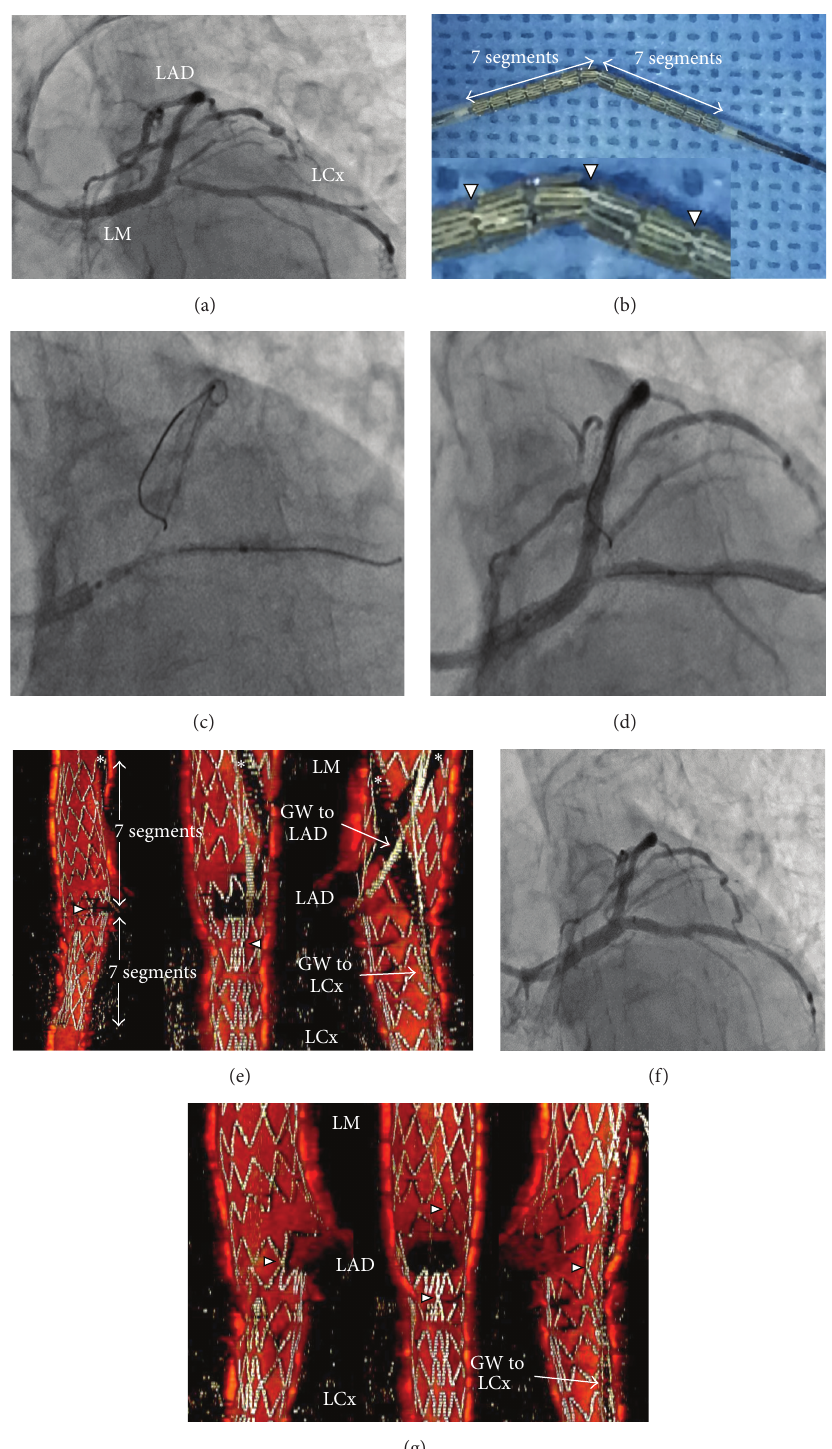
Figure 2: First clinical case treated with the bent stent technique. (a) Baseline coronary angiography (CAG). (b) 3.5 × 18mm two-link Biolimus-eluting stent isbent at thecenter articulation with laterally positioned links. Stenting position isconfirmed by X-ray fluorography (c) and CAG (d). (e) Instant stent-accentuated three-dimensional optical coherence tomography (iSA3D-OCT) shows free carina type and distal cell rewiring. After kissing balloon dilation is performed, final CAG (f)and iSA3D-OCT (g) showa good result. LM: left main coronary artery; LAD: left anterior descending artery; LCx: left circumflex artery; GW: guidewire. Arrowheads and asterisks indicate links and guidewire shadow artifacts,